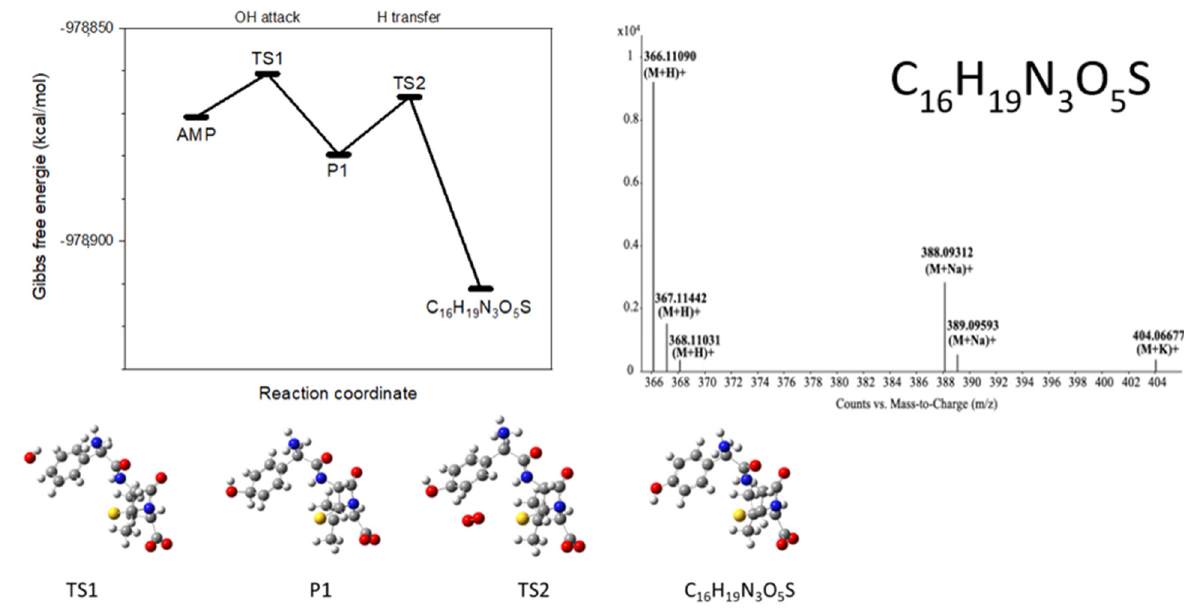
Figure 7. Characteristic reaction pathway in the degradation of ampicillin leading to the UPLC/MS/MS-identified Product.